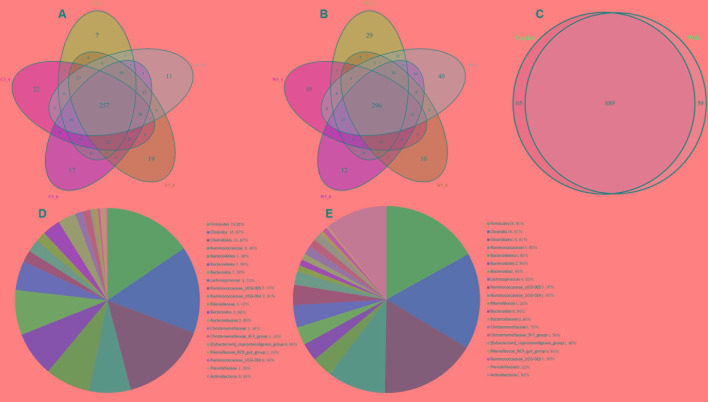
Venn diagram and pie charts. The Venn diagrams show the numbers of OTUs (97% sequence identity) that were shared or not shared by CMD and WMD individuals, respectively, depending of overlaps. For this presentation, two individuals had to be combined (e.g., C1_2) thereby reflecting the number of OTUs shared by both individuals. (A) The number of OTUs shared by CMD. (B) The number of OTUs shared by WMD. (C) The number of OTUs shared by CMD and WMD. The pie diagram shows the 20 most abundant taxa (calculated over the combined dataset) in CMD and WMD. (D) CMD, (E) WMD.